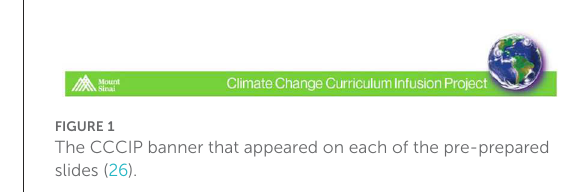
FIGURE1 The CCCIP banner that appeared on each of the pre-prepared slides (26).